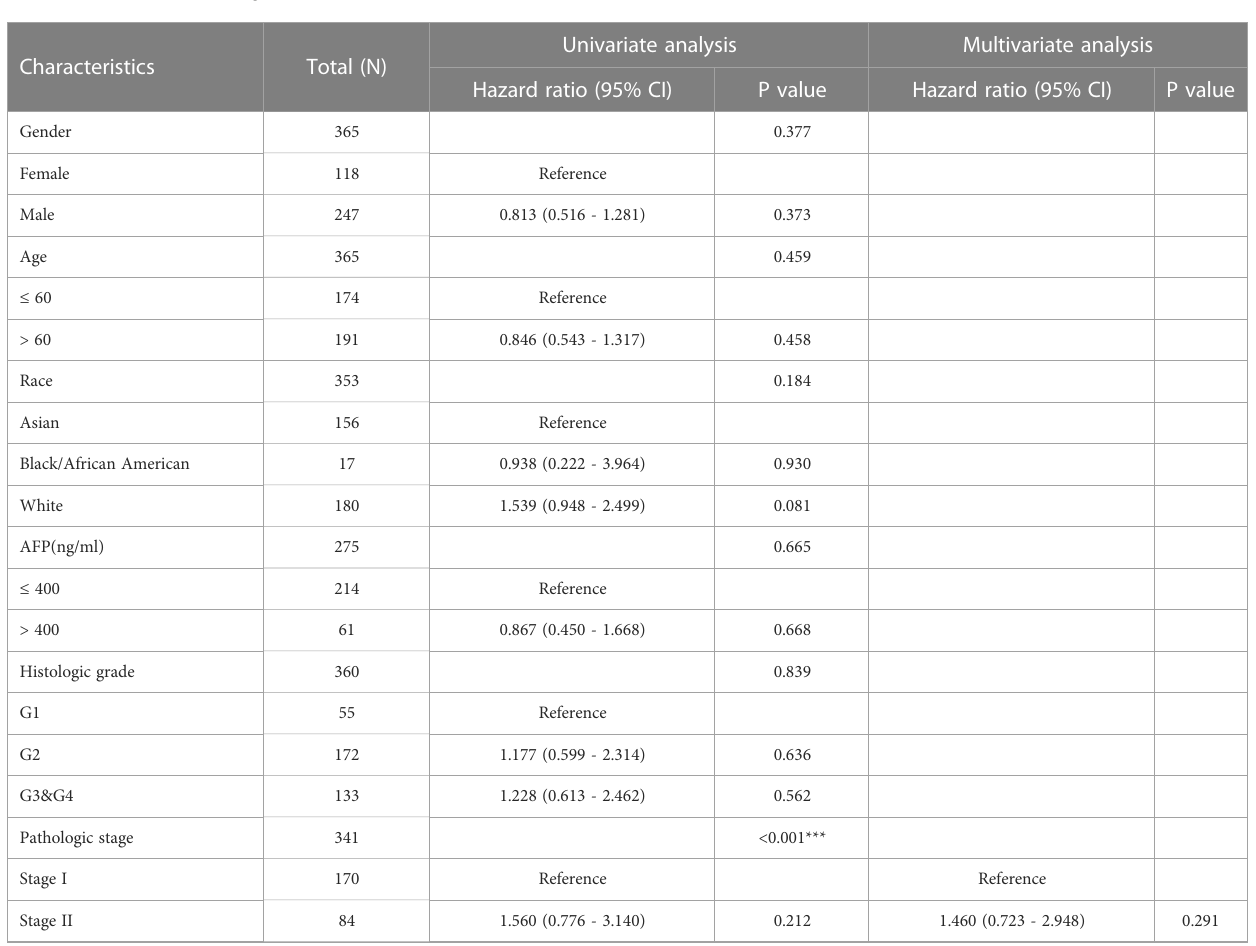
TABLE 2 Overall survival